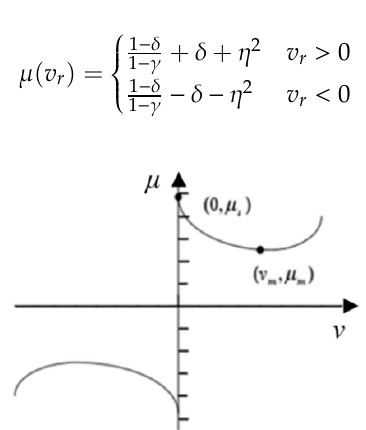
Figure 13. The nonlinear Stribeck friction model.